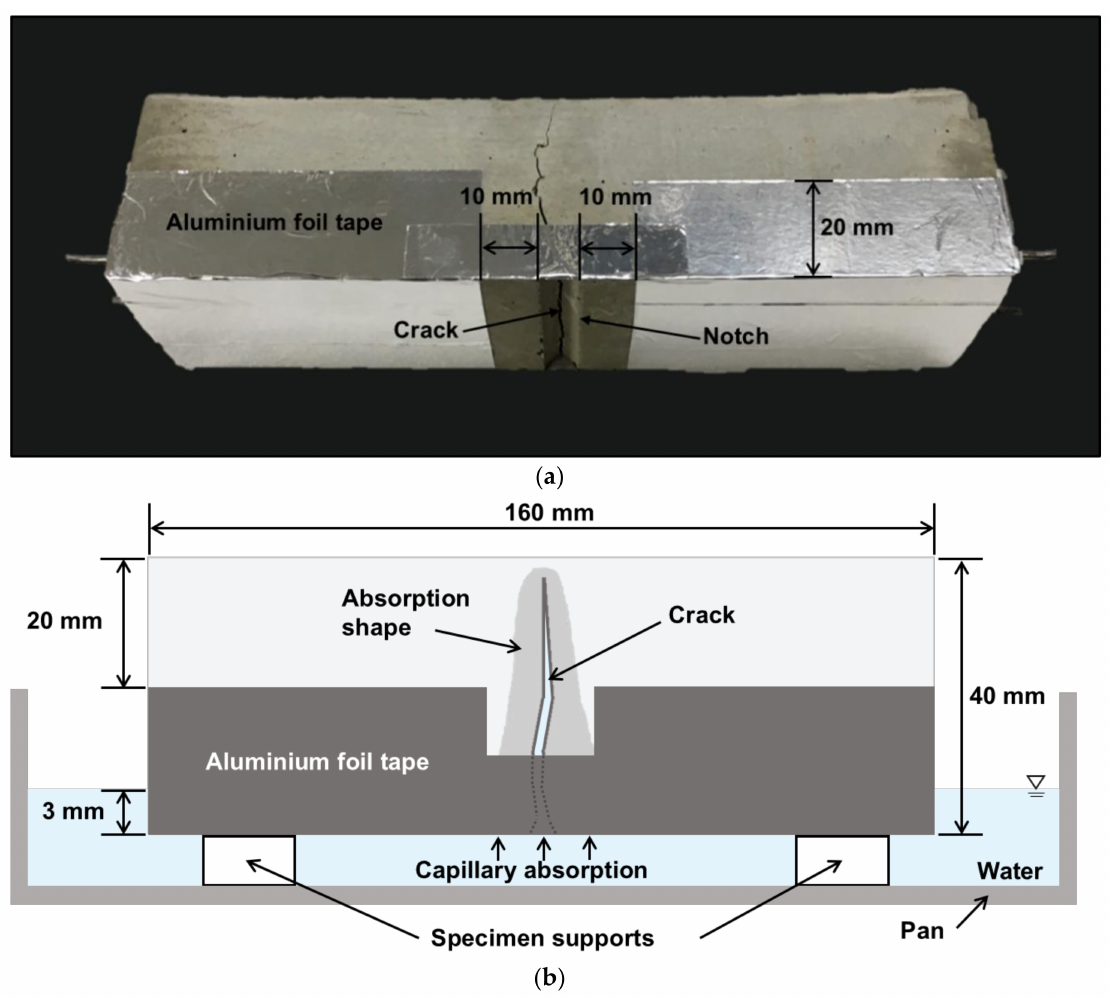
Figure 4. ( a ) Specimen sealed with aluminum foil tape; ( b ) Illustration of capillary water absorption